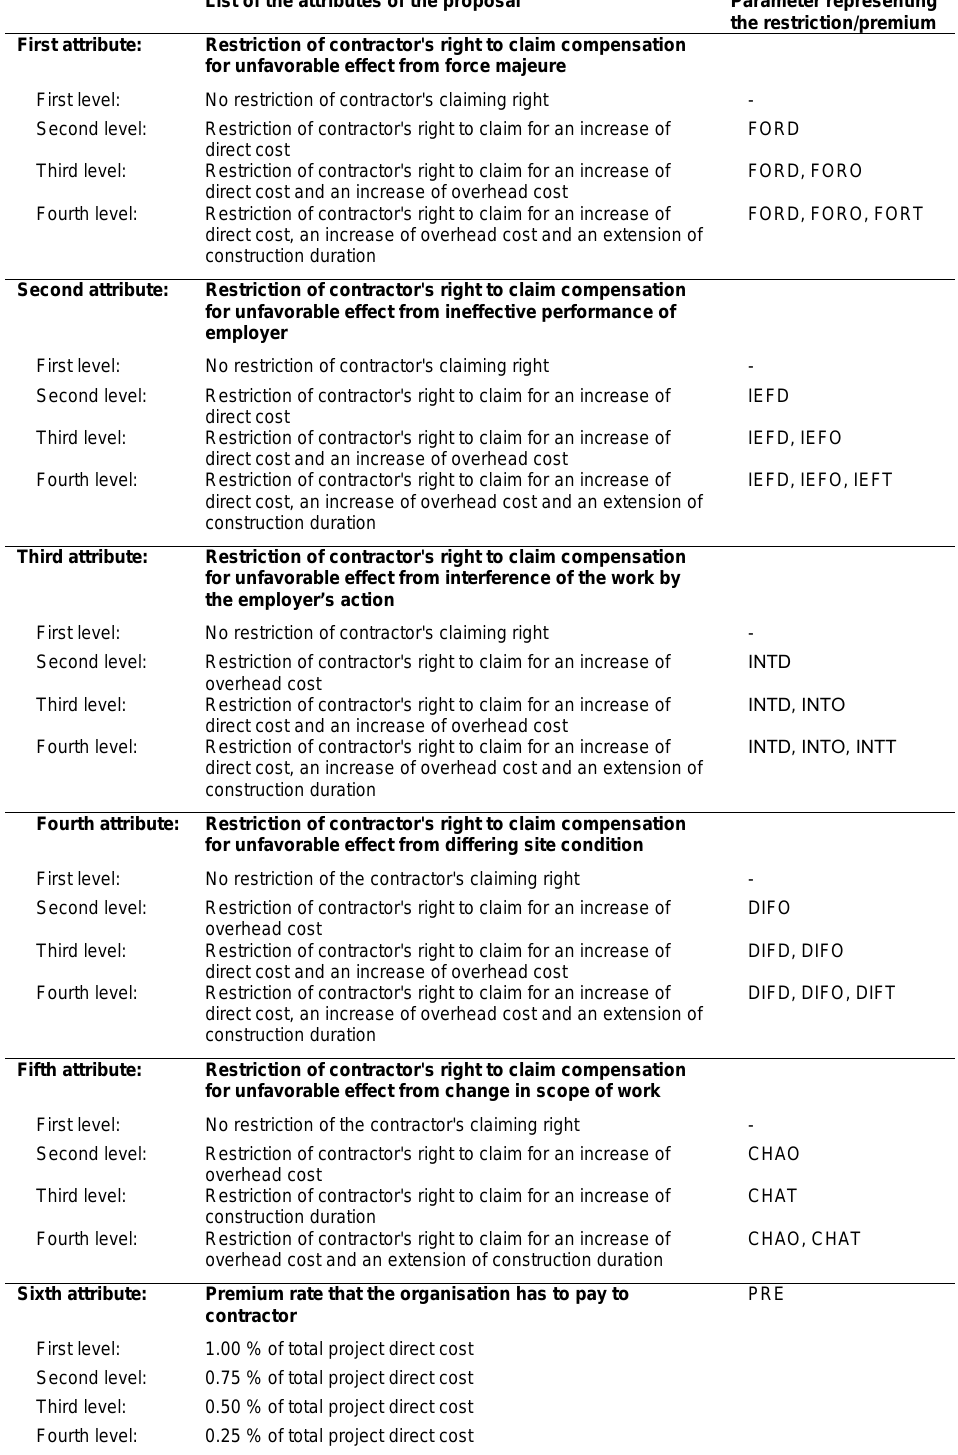
Table 1: List of the proposal attributes and the characteristic of each attribute List of the attributes of the proposal Parameter representing the